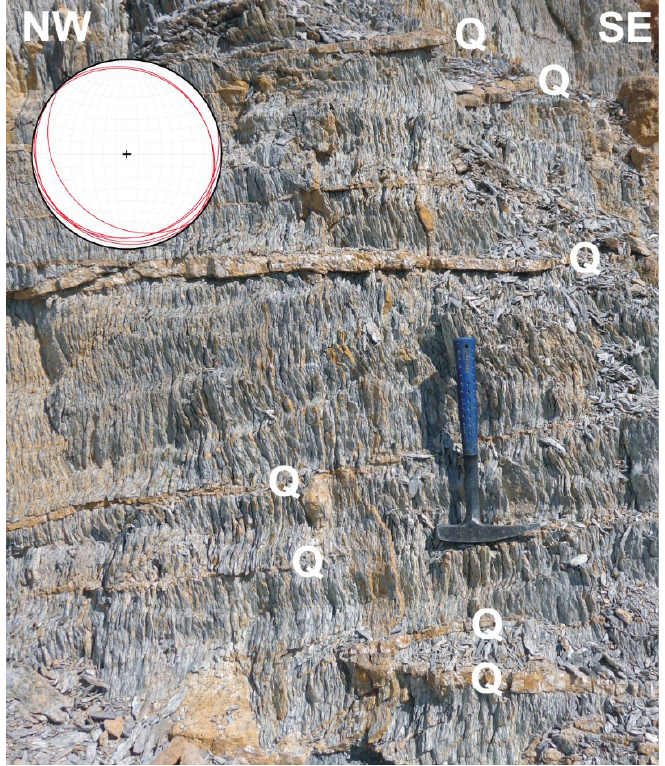
Figure 11. Sinistral calcite-filled fracture system with a minor fault (left) and a parallel fracture (right). Between the fault and the fracture is a parallel array of widened, right-stepping Riedel shears (marked by “R”). The red pocket knife for scale is positioned parallelly to the calcite shear veins. ( A ) Natural appearance of structures. ( B ) Fractures marked by black lines for easier perception.